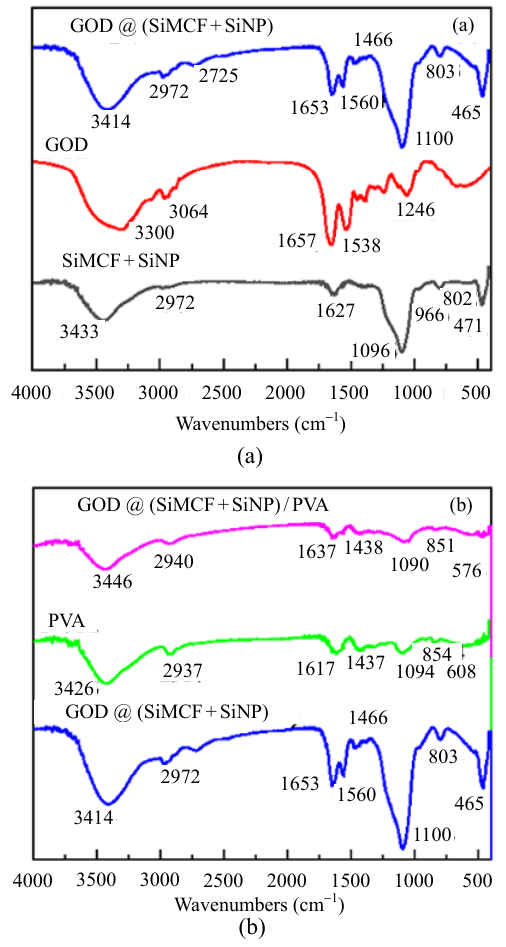
Fig. 4 FT-IR spectra of the GOD @ (SiMCFs + SiNPs) / PVA